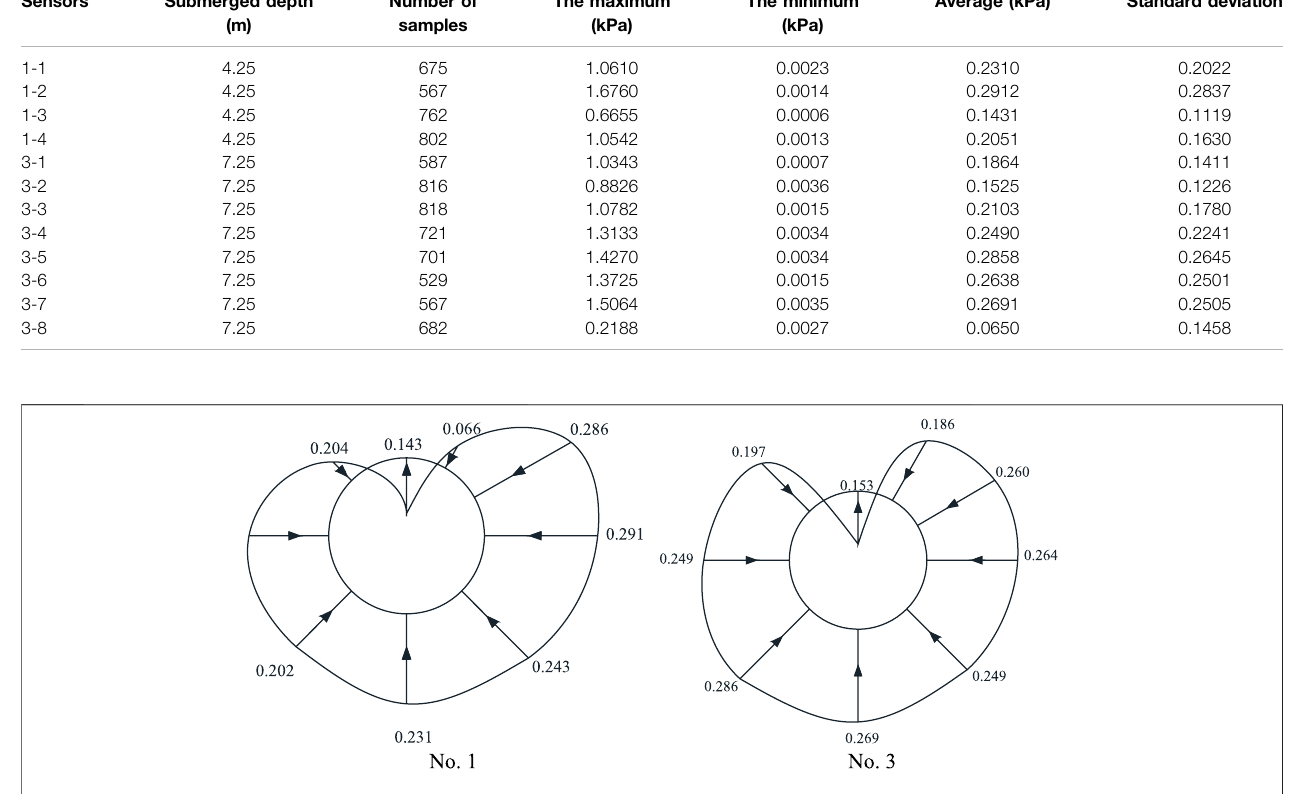
FIGURE 12 | Distribution diagram of hydrodynamic pressure along pile circumference.